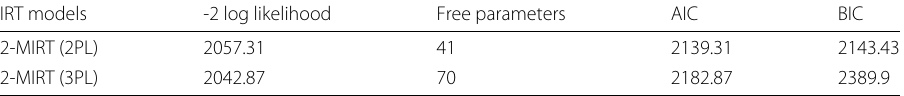
Table 11 Goodness of fit statistics for 2-MIRT (2PL) and 2-MIRT (3PL) models IRT models -2 log